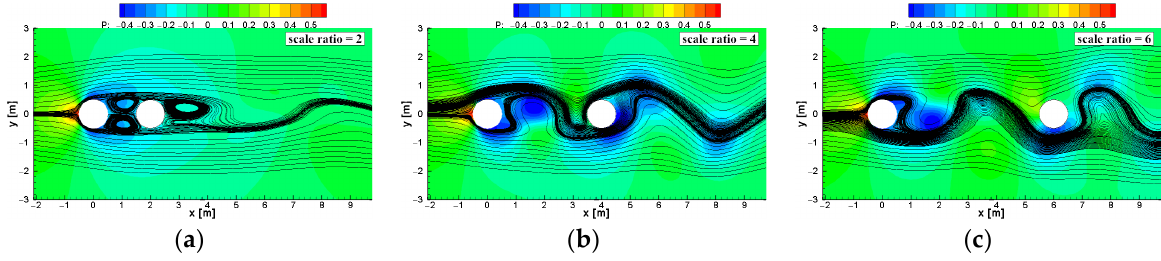
Figure 17. Contour maps of pressure and streamlines around two circular cylinders with spacing ratios of ( a ) 2, ( b ) 4, and ( c ) 6 at t = 400 s ( Re = 100).